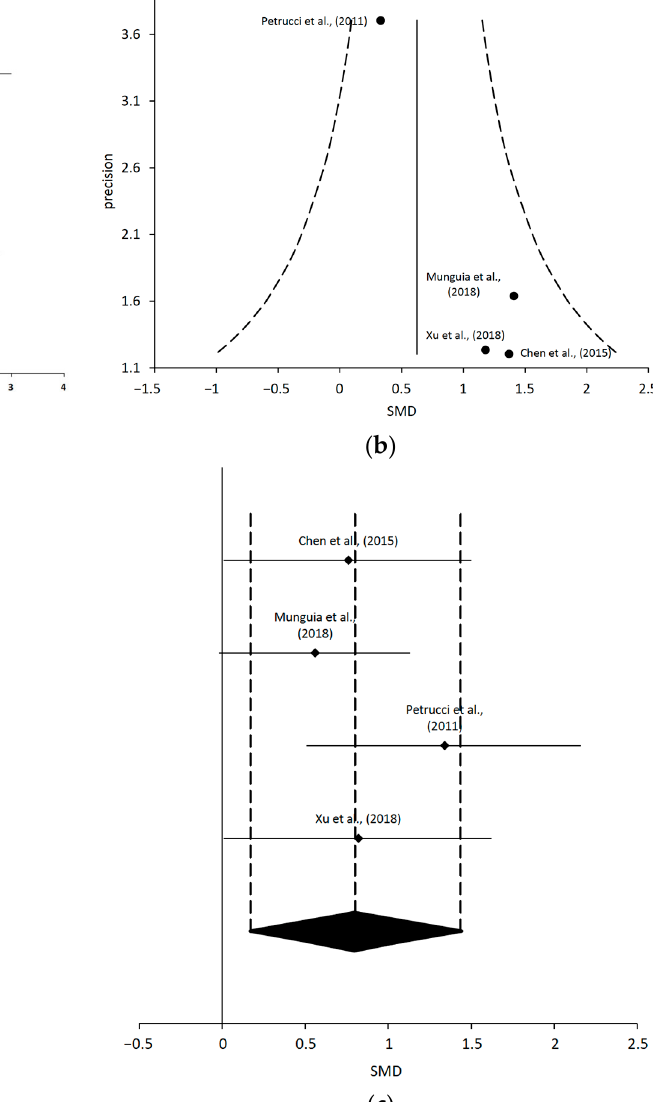
Figure 6. Synthesis forest and funnel plot of low-level laser therapy on pain intensity variable [18,62,64,67]. ( a ) The forest plot summarizes the results of included studies (standardized mean differences (SMD) and weight). The small squares represent the point estimate of the effect size and sample size. The lines on either side of the box represent a 95% confidence interval. ( b ) Funnel plot aims to assess the existence of publication bias. ( c ) Sensitivity plot.